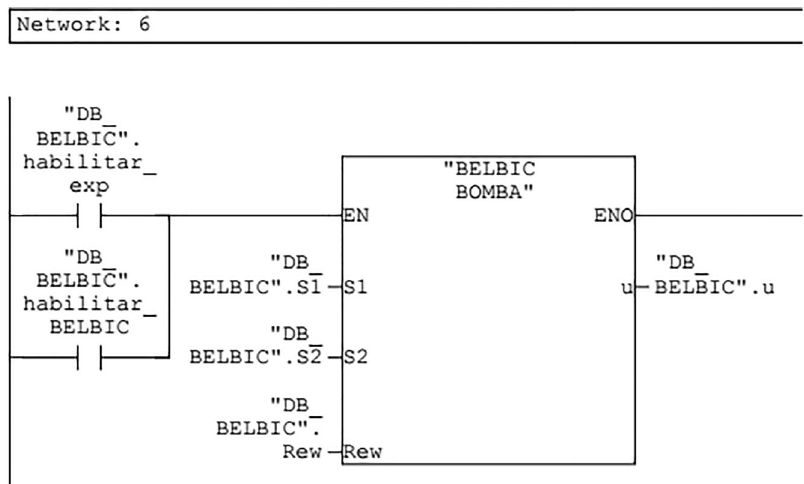
Figure 13. BELBIC controller PLC block.